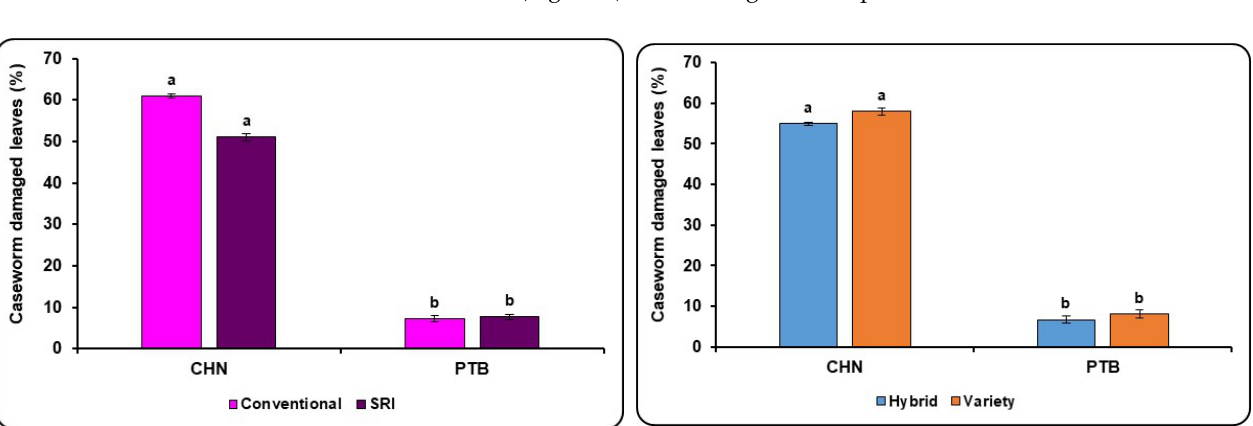
Figure 5. Caseworm incidence with different methods of rice cultivation and cultivars. Means with the same letter are not significantly different by Tukey’s HSD ( p = 0.05) at each location.